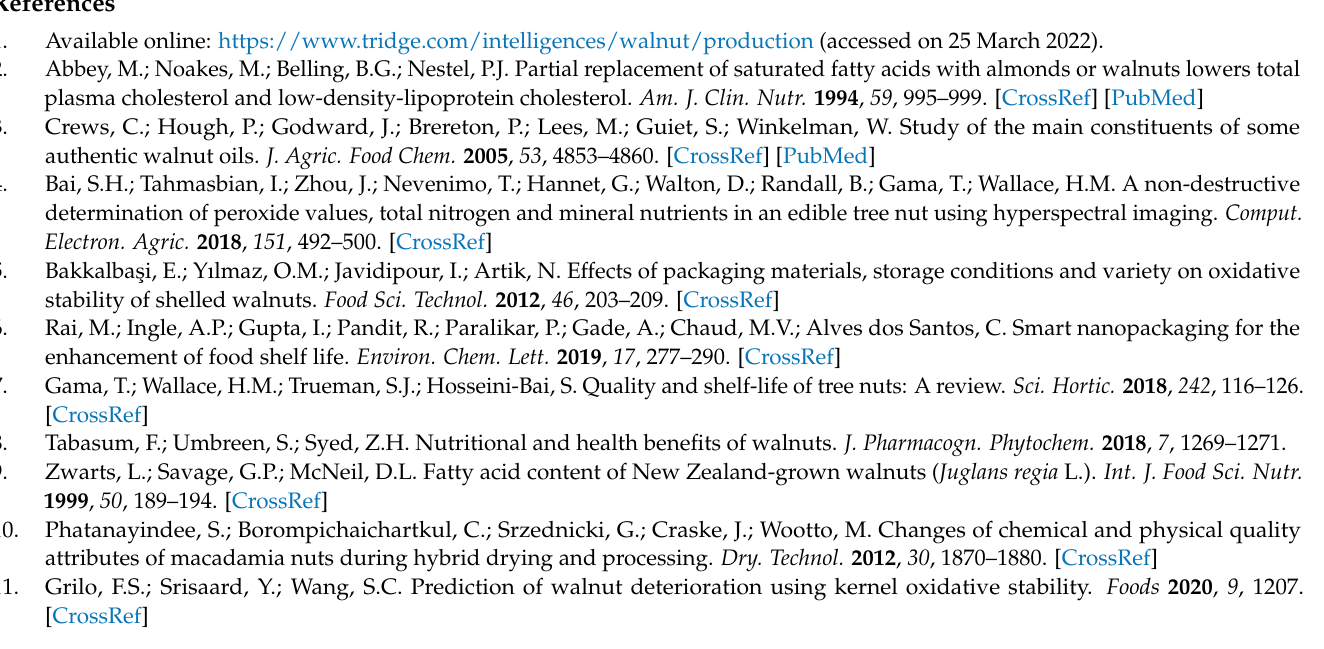
Table S2: Changes in oil sensory properties during storage; Table S3: Correlations between evolu- tion of volatile compounds and sensory attributes of kernels during storage; Table S4: Correlations between evolution of volatile compounds and sensory attributes of oil during